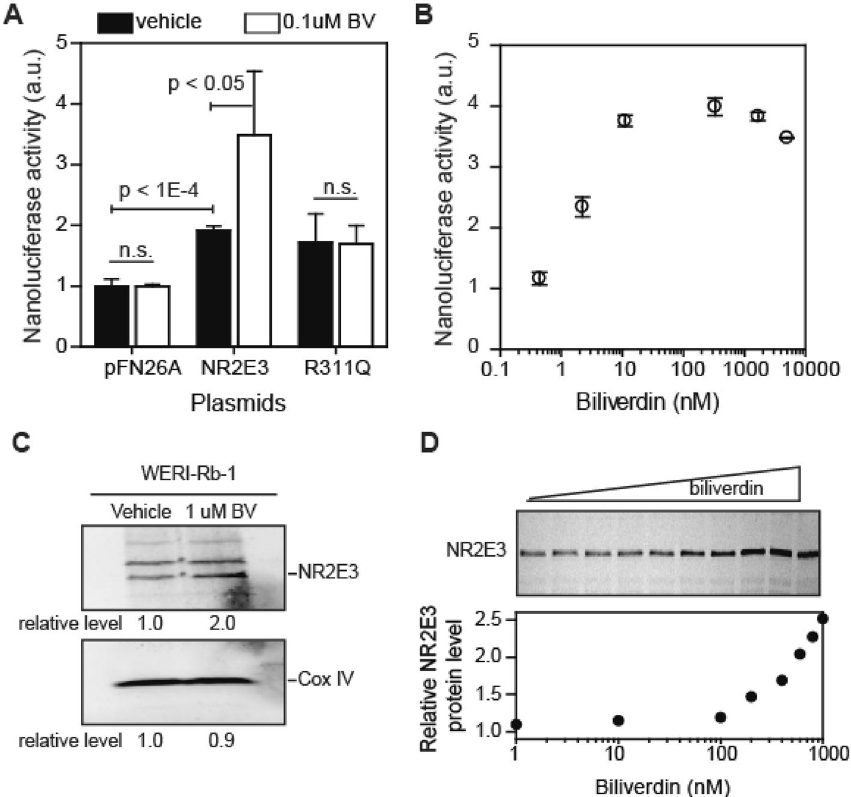
Figure 3. Biliverdin regulates NR2E3 in cells. ( A , B ) Reporter gene expression analysis in 293F cells. Cells were transfected with a reporter plasmid encoding nanoluciferase under the control of 9 × GAL UAS and plasmids (pFN26A derivatives) encoding GAL DBD -NR2E3 fusion protein. A day after transfection, cells were treated with vehicle (0.1% DMSO) or biliverdin for 3 h. Nanoluciferase activity was measured using Vivazine substrate (average and standard deviations, n = 3). ( C , D ) Biliverdin increased NR2E3 protein level in WERI-Rb-1 cells. WERI-Rb-1 human retinoblastoma cells were incubated with vehicle (0.1% DMSO) or biliverdin (1 μM for C and varying concentrations for D ) for 24 h. Western blot results (1:1000-fold diluted antibody) are shown.